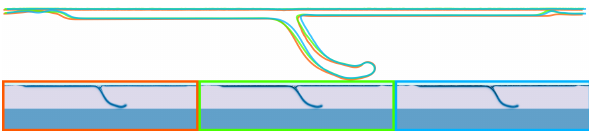
Figure 10. 1550K isotherm for models 12 (left/orange), 14 (cen- ter/green), and 16 (right/blue). Surface plates are 80km thick and have a maximum viscosity of 10 23 Pas, 10 24 Pas, and 10 25 Pas for models 12, 14, and 16 respectively. Slabs have a maximum viscosity of 10 23 Pas. Subfigures show viscosity for each